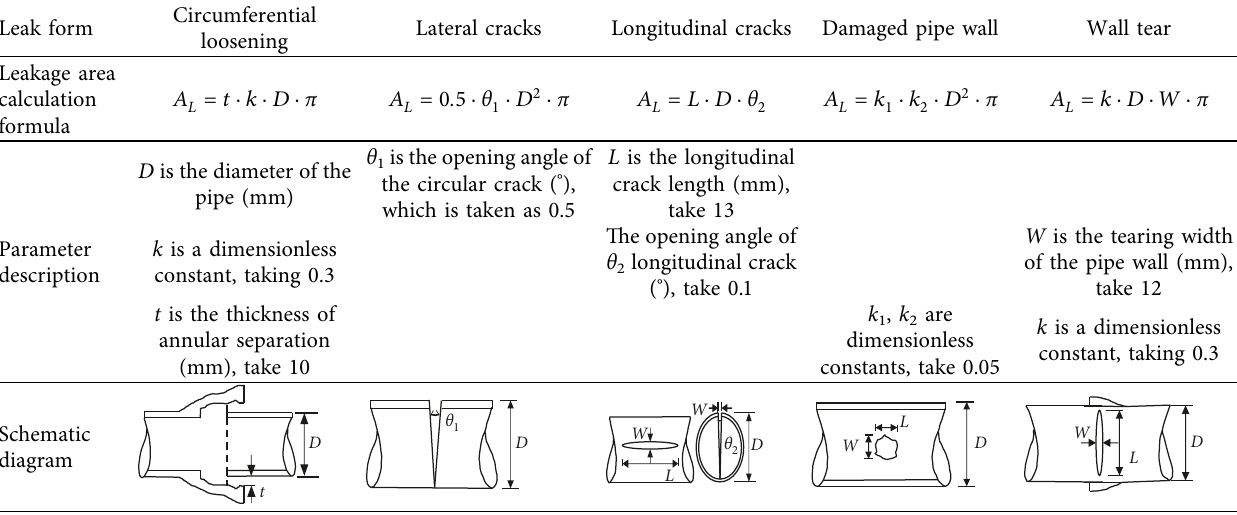
Table 1: Pipe leakage forms and their calculation formula (according to document [7]).